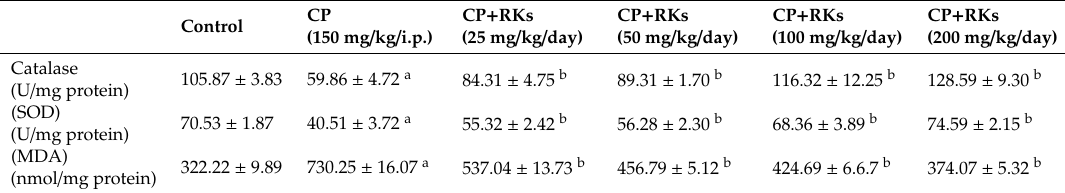
Table 1. E ff ect of di ff erent doses of Raspberry ketones (RKs) on some biochemical indicators of oxidative stress, namely MDA, Catalase and SOD activity, in lung tissue. Results are as expressed + S.E. n = 6 for each experimental group Superscript letters indicate a significant di ff erence at p > 0.05 using one-way ANOVA followed by the Bonferroni’s test for multiple comparisons. a Indicates significant di ff erences from control mice, b Indicates significant di ff erences from CP.